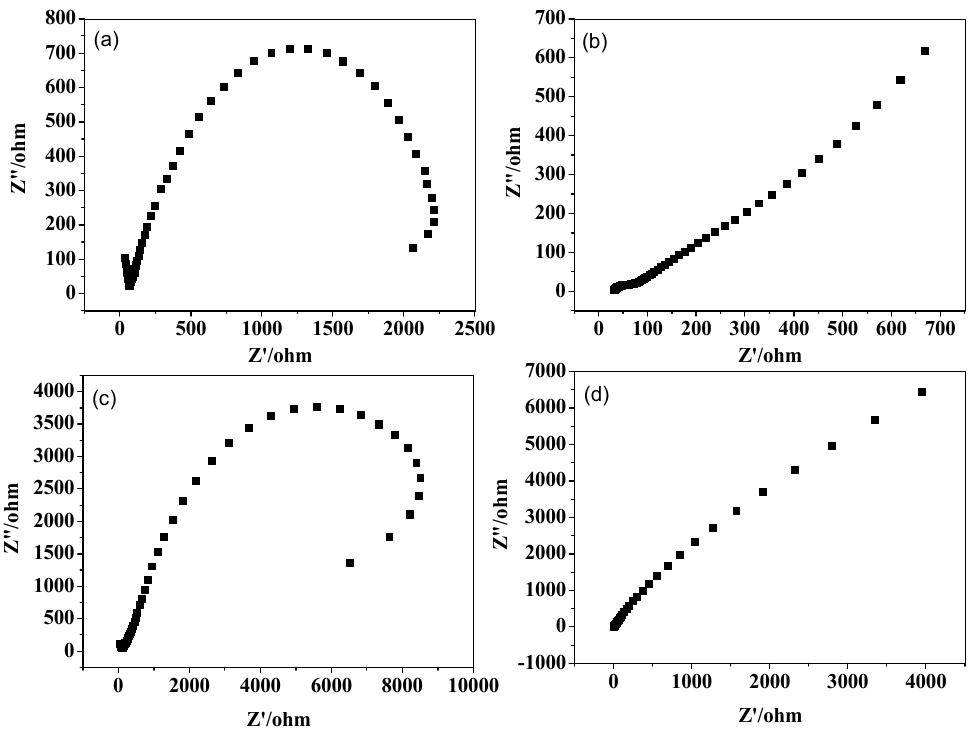
Figure 8. Nyquist plot of ( a ) Au, ( b ) PACHA, ( c ) PANI, and ( d ) PHA in citrate buffer (pH 5) and 1.4 × 10 − 6 M H 2 O 2 solution.